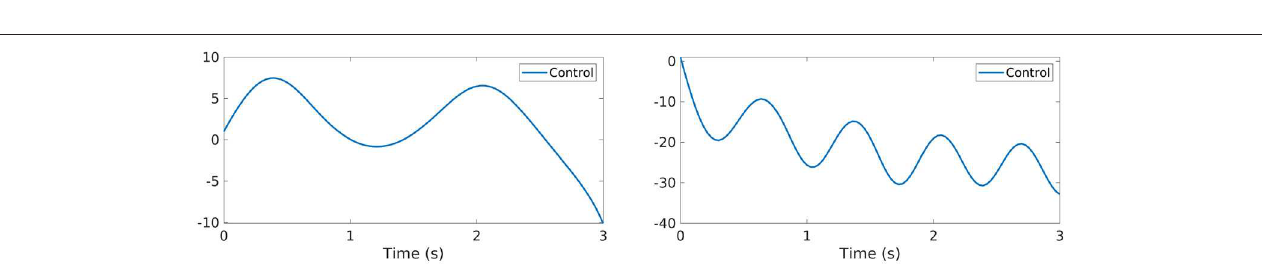
FIGURE 11 | Evolution of the uncontrolled (left) and controlled (right) dynamics of the Kuramoto model [Equation (23)] with N K < 0 (bottom).